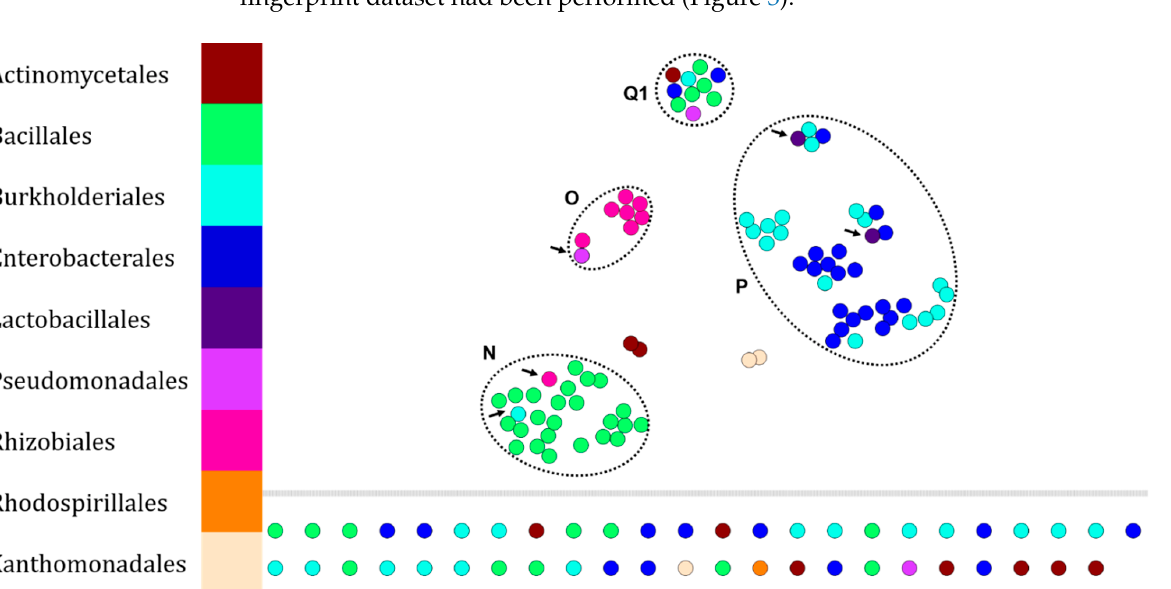
Figure 4. Visualization of 138 lipid fingerprints of environmental bacteria (138 isolates—BNSB’s database) set by t-SNE. Each node represents the lipid fingerprint of an isolate and is colored according to the taxonomic order of the organism. Arrows indicate illogical attributions within clusters (noted Q1, N, O and P).